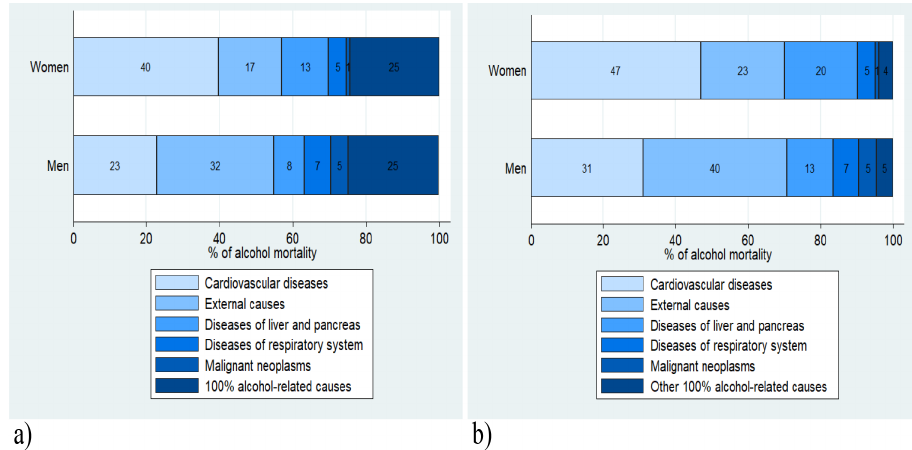
Figure 5. Number of deaths due to excessive alcohol consumption, depending on causes of death, proportion in alcohol mortality (%), men and women, 2018. (a) all causes 100% caused by alcohol are allocated to a separate group; (b) causes 100% caused by alcohol are distributed by the main groups of causes. Source : author’s calculations based on the RLMS and Russian Fertility and Mortality Database